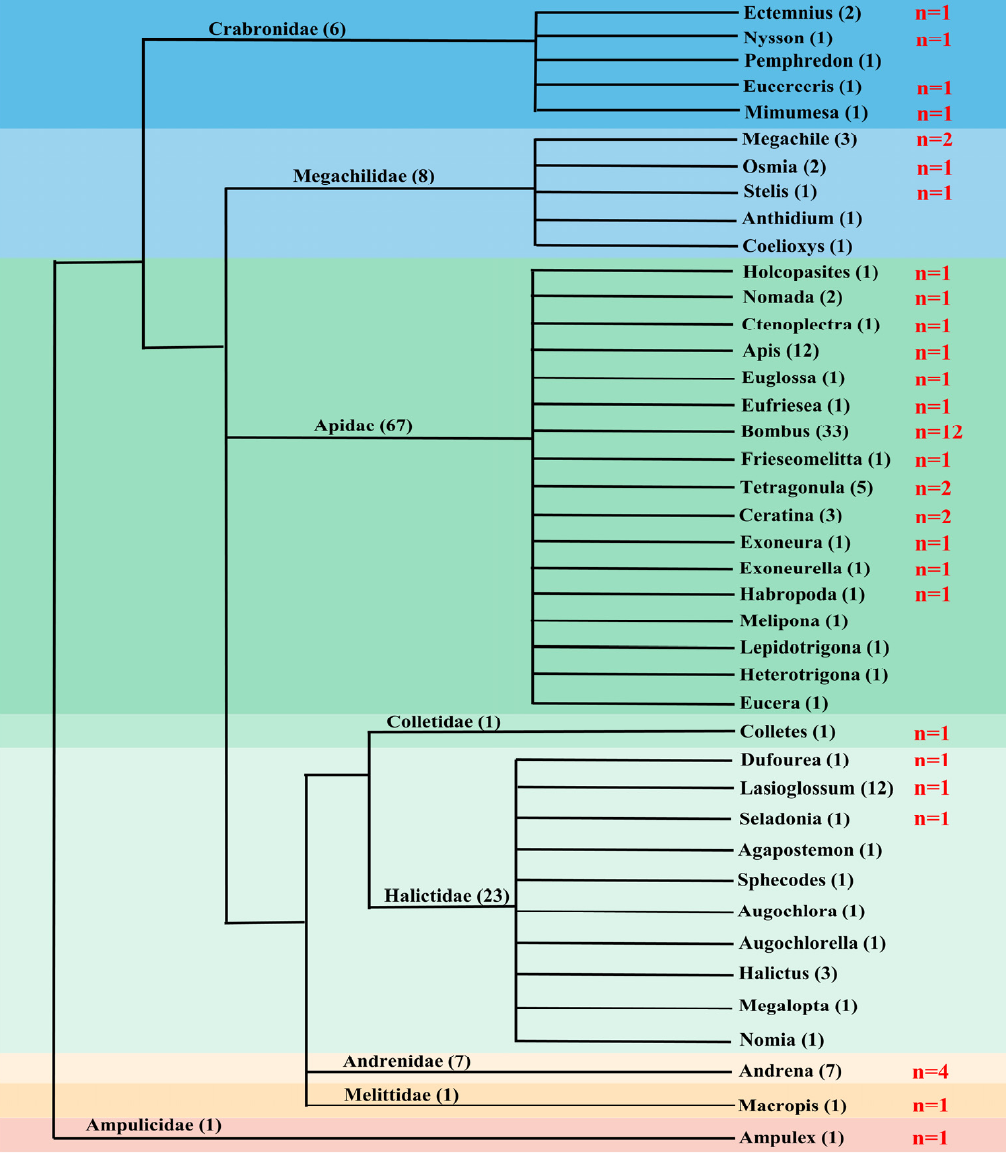
Figure 1. Distribution of piggyBac ( PB ) transposons in Apoidea among different genera. The tree on the left is the phylogenetic relationship between all genera in which transposons were detected, and different colors represent different families. The numbers in parentheses are the number of species in the families and genera used to examine, and “ n ” represents the number of species with PB transposons detected in each